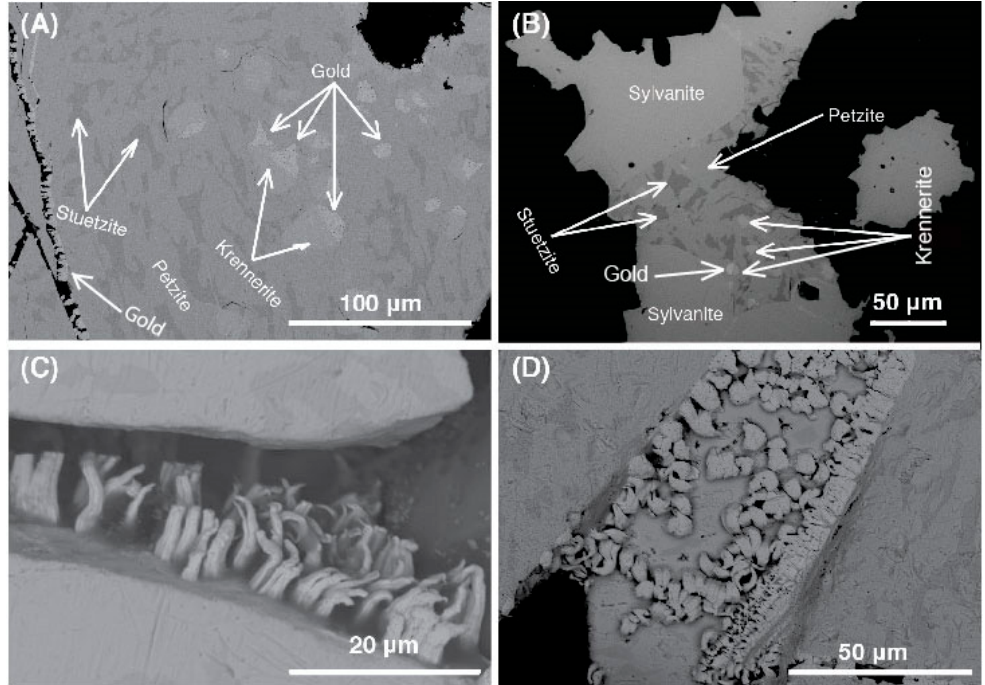
Figure 3. Mineralogy and microstructures of Au–(Ag) telluride ores at Sandaowanzi deposit [7,8]. ( A ) Native gold along intragranular cracks in the telluride grains and native gold–krennerite pair included in petzite–stuetzite symplectite. ( B ) Native gold and krennerite patches contained a petzite–stuetzite symplectite in association with sylvanite. ( C ) Bamboo shoot-like native gold grains along intragranular cracks in telluride grains. ( D ) Irregular shaped native gold grains within a cavity in gold tellurides.